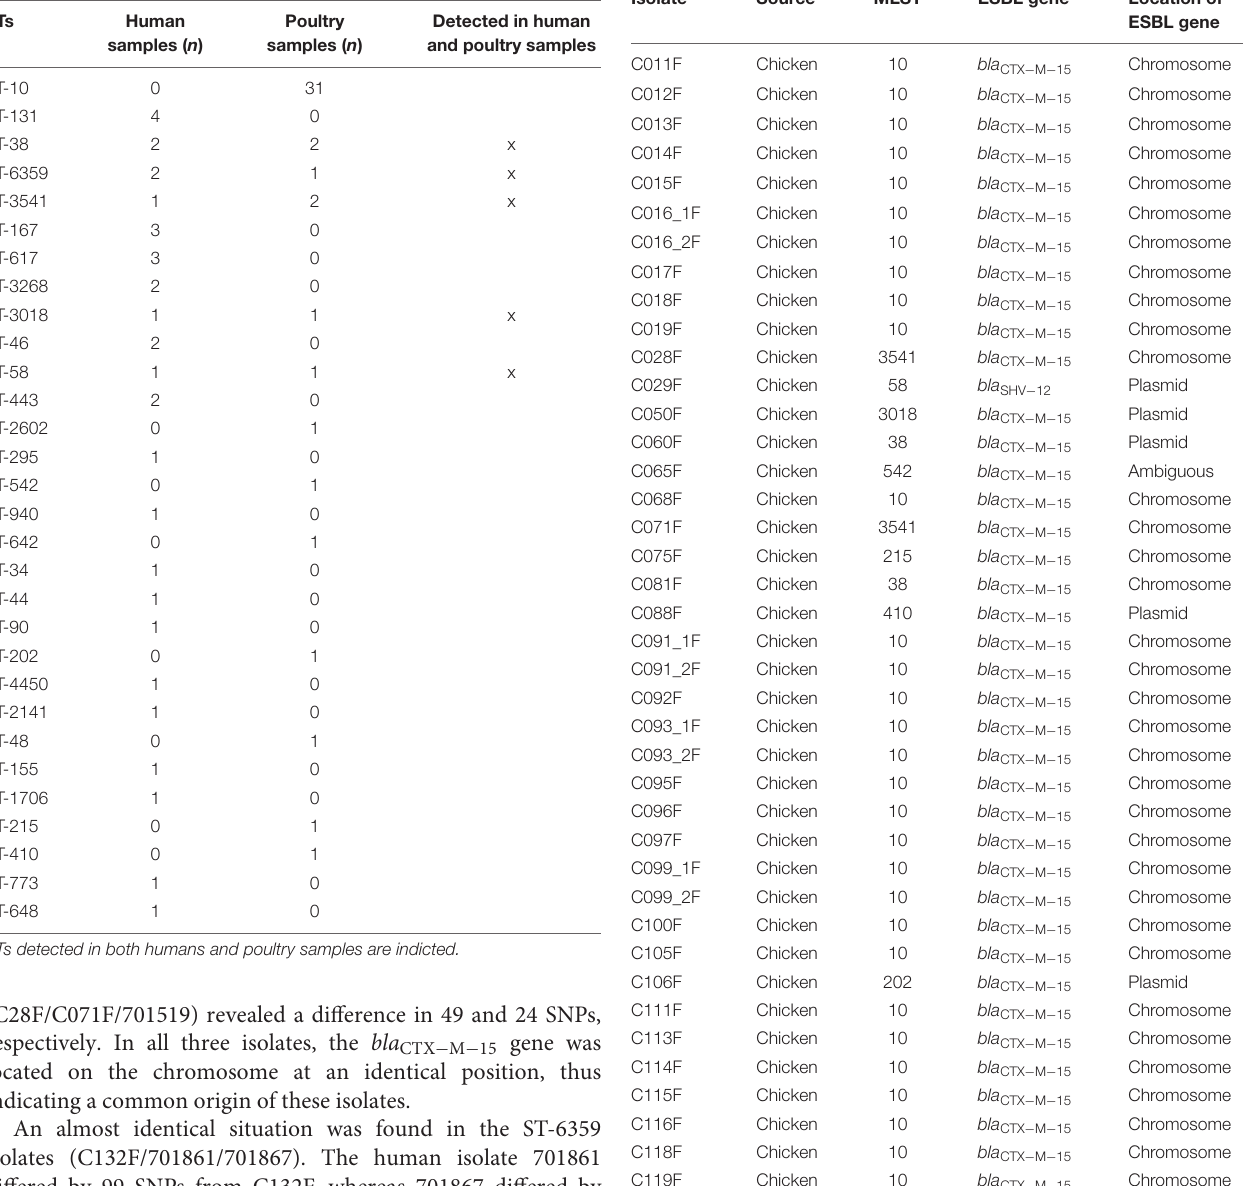
TABLE 2 | Characteristics of the sequenced Escherichia coli isolates.